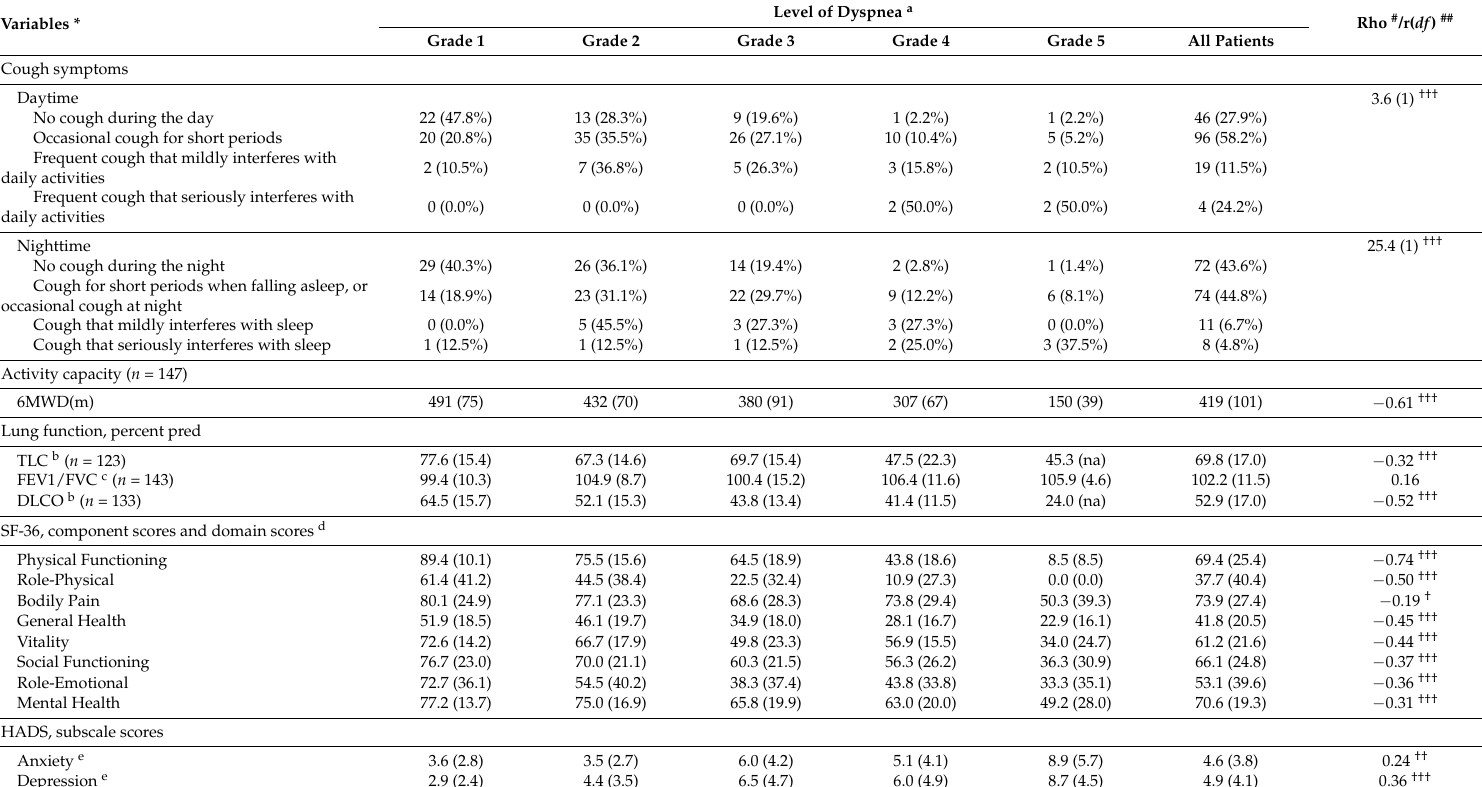
Table 3. Association of physiological and psychological factors with